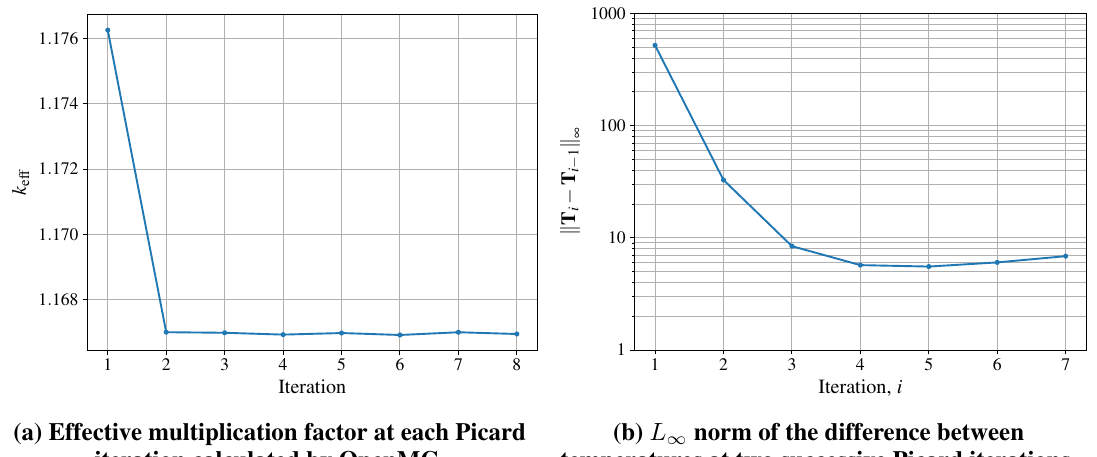
Figure 4: Convergence of the Picard iteration for a coupled OpenMC-Nek5000 simulation of the full-length fuel assembly.